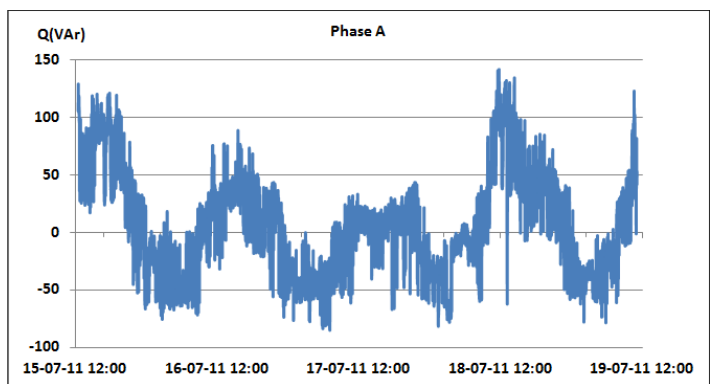
Figure 18. Reactive power of phase A for 15–19